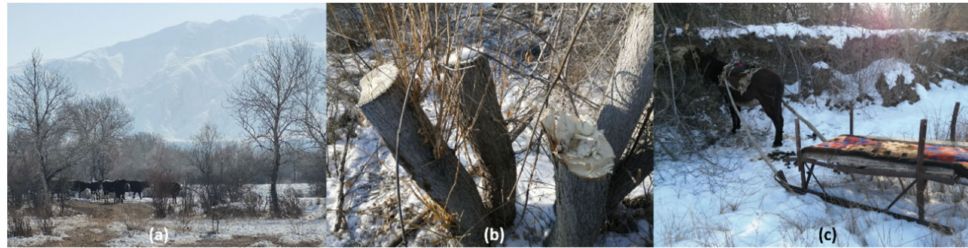
Figure 5. Forest use: ( a ) Wood pasture in the wintery riparian forest. ( b ) Illegal cuttings of two consecutive years. ( c ) Donkey ledge ready for transporting illegally harvested fuel wood. Ak- Tal Village, 2020.